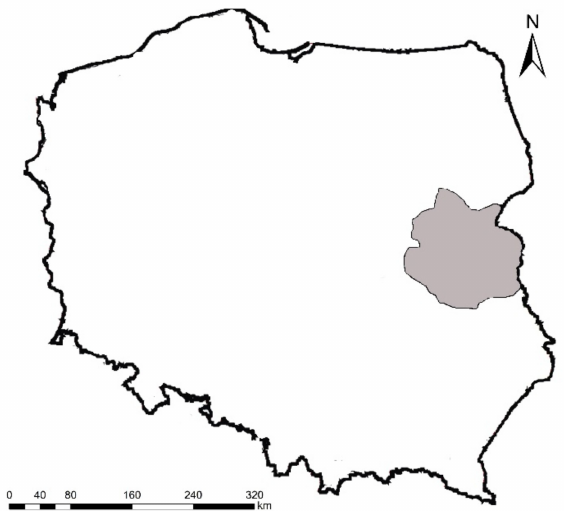
Figure 1. Location of the Podkraina Południowopodlaska Region in the eastern part of